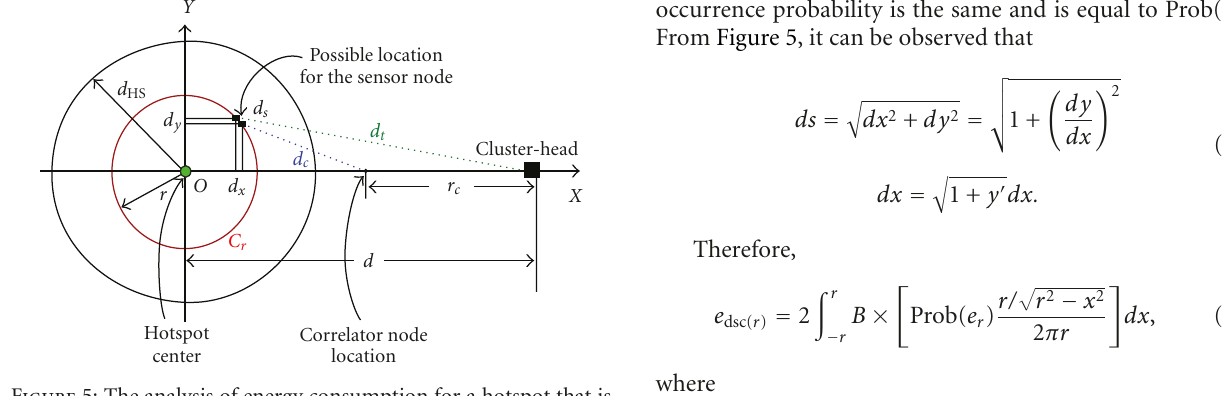
Figure 5: The analysis of energy consumption for a hotspot that is located at the origin. The hotspot has distance d to the clusterhead and correlator radius r c is used within the